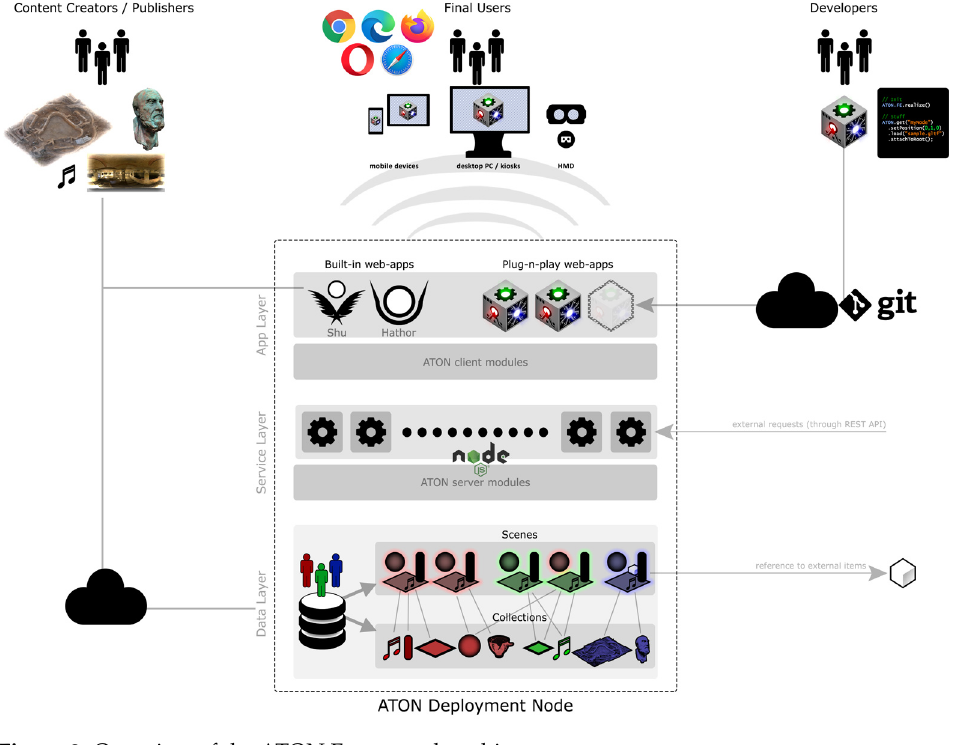
Figure 2. Overview of the ATON Framework architecture.